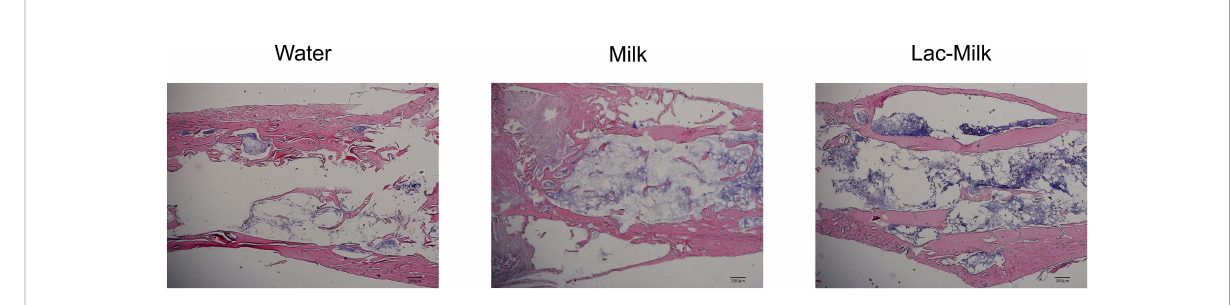
FIGURE 6 Representative HE stained images of the fracture site 28 days after surgery.